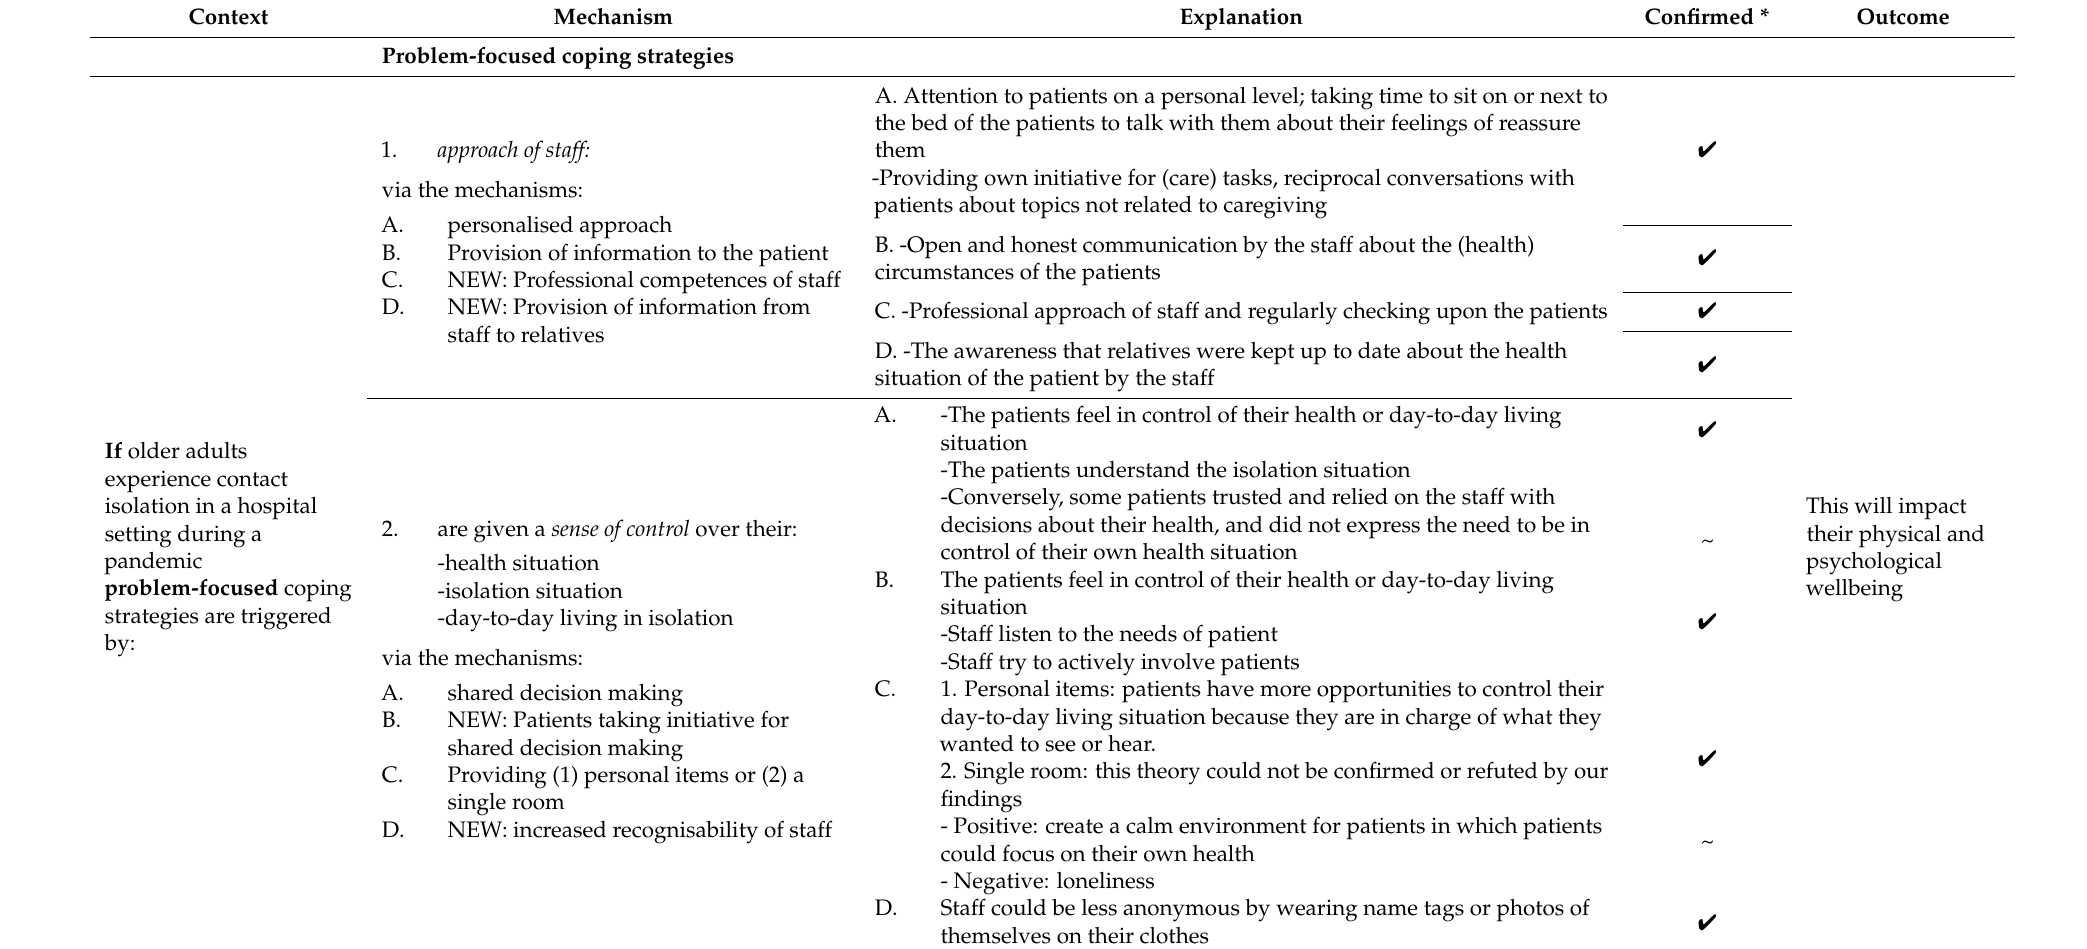
Table 4. Overview of the program theories about coping strategies in this specific context and